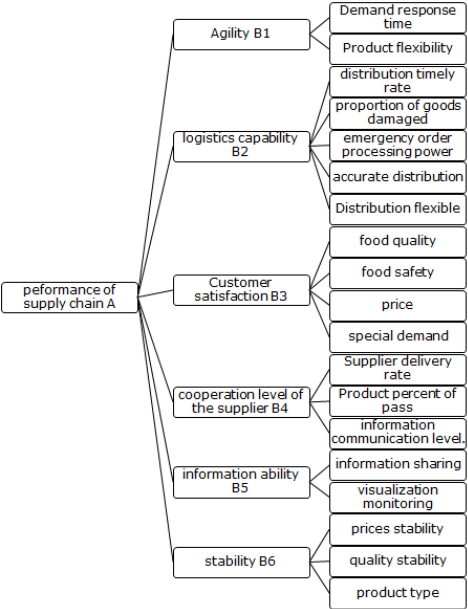
Figure 2 . Supply chain performance